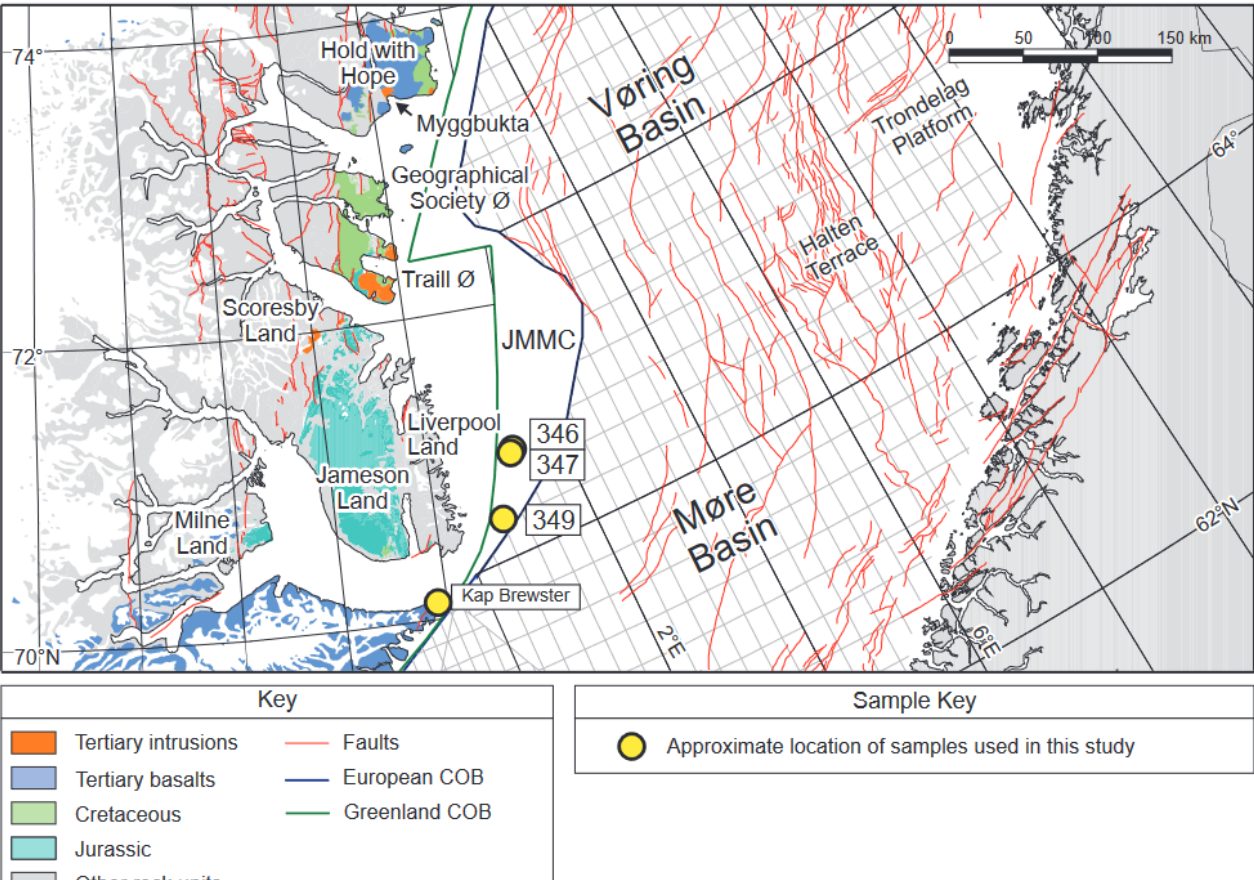
Figure 2. Reconstruction of the Norway-Greenland Sea region, for the time immediately prior to the onset of seafloor spreading in the Paleogene, adapted from Scott [10]. Locations of Deep Sea Drilling Project sites 346, 347 and 349 are only approximate given uncertainties in the reconstructions and the pre-break up shape and location of the Jan Mayen Microcontinent (JMMC). The reconstruction shows the former proximity of the borehole sites to the East Greenland margin. The grid displayed for the eastern part of the area shows Norwegian quadrants and blocks.